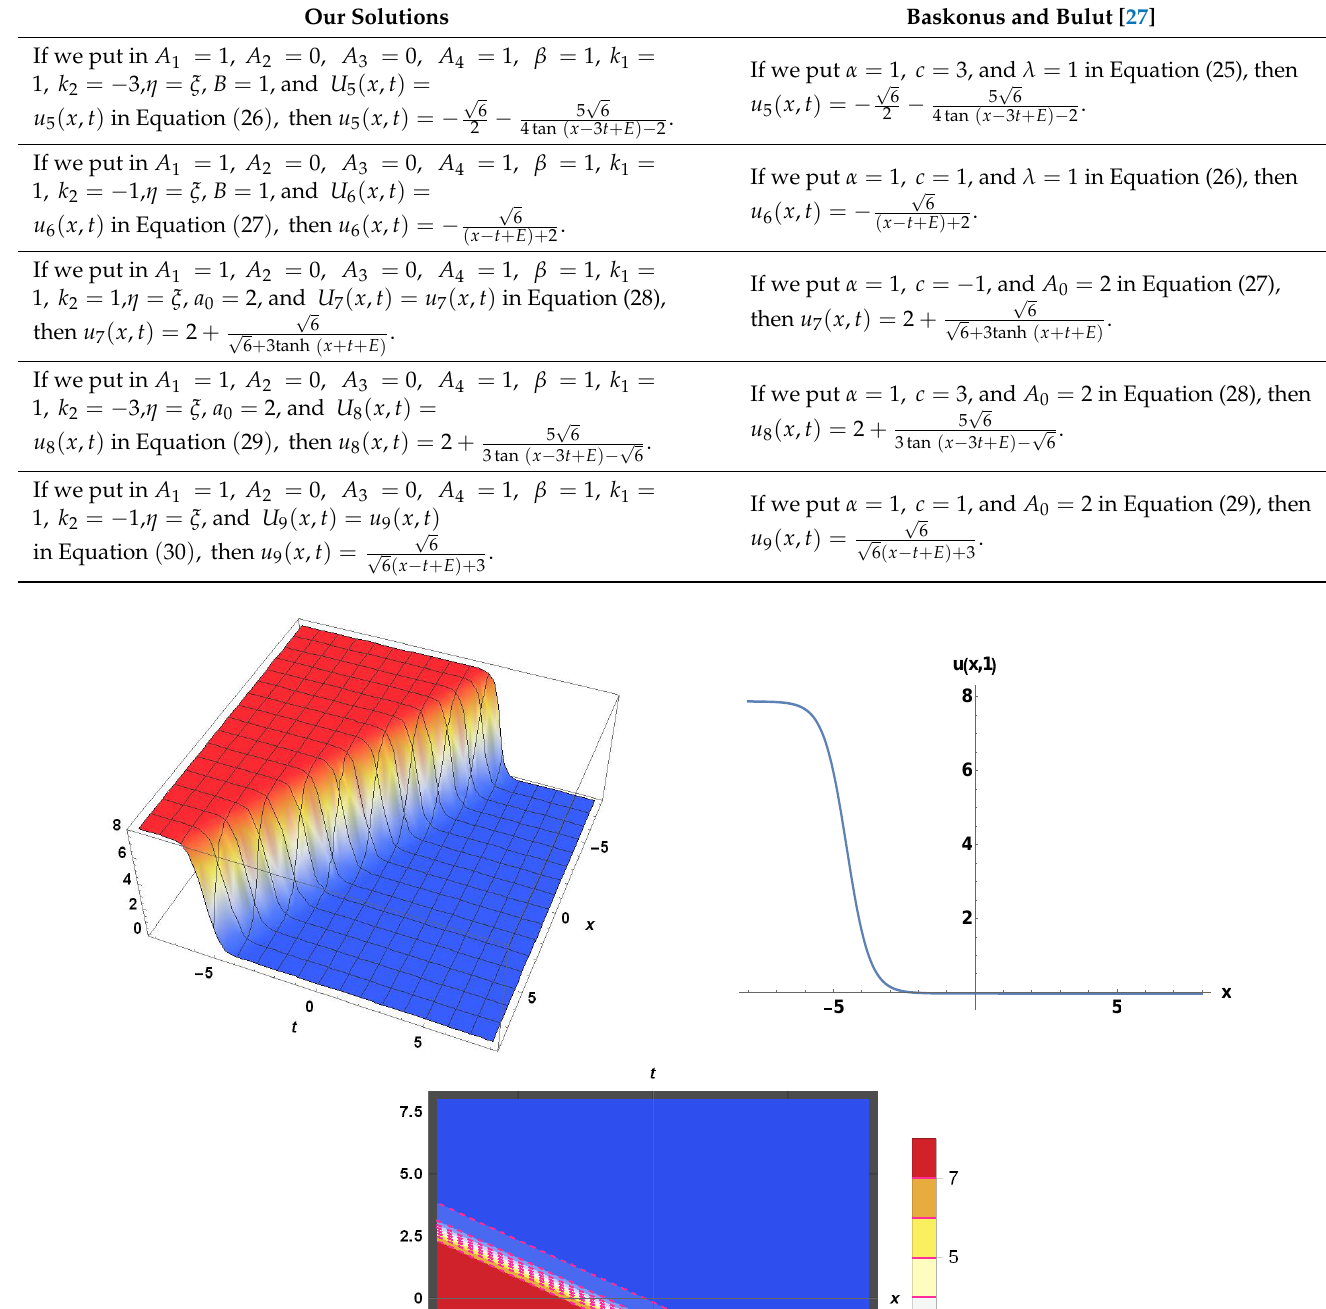
Figure 2. The solitary wave view of the 3D, 2D, and contour plots of U 2 ( x , t ). 30